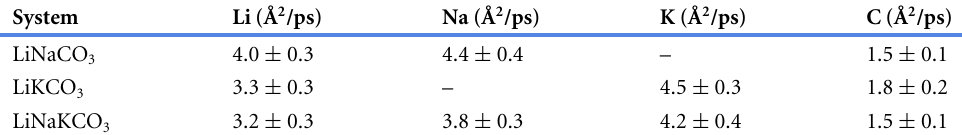
Table 3 Self-diffusion constants of each ion in each of the systems